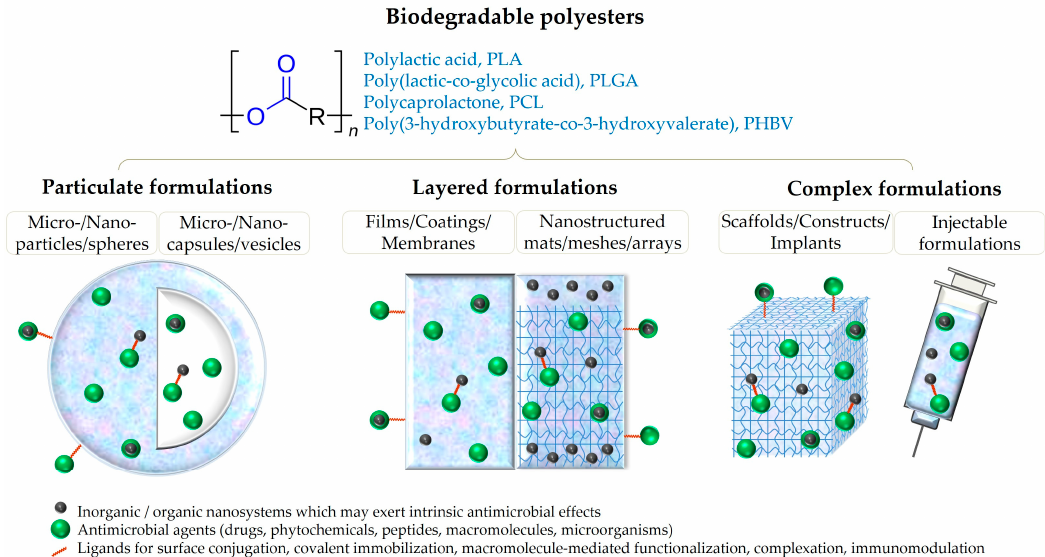
Figure 1. Schematic representation of antimicrobial biopolyester-based formulations.